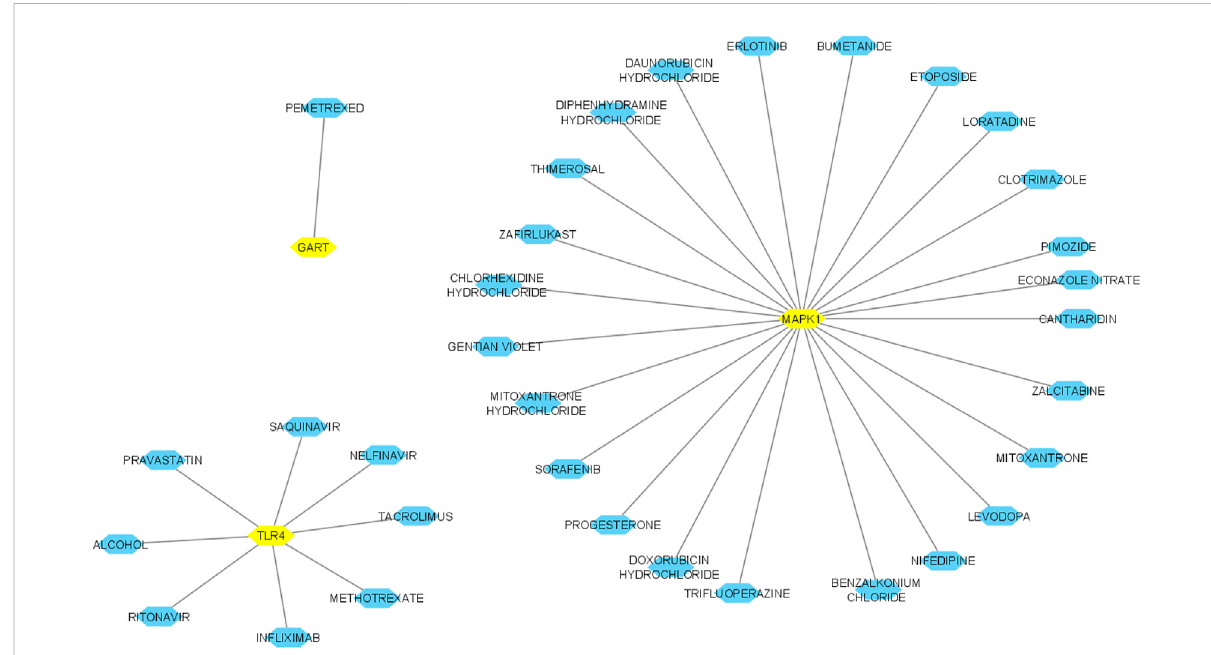
FIGURE 12 Interaction of hub geneswith FDA-approveddrugs. Yellow nodes indicated the hub nodes, and other nodes showed the interacting drugs. The interaction was identi fi ed and visualized using the DGIdb database and